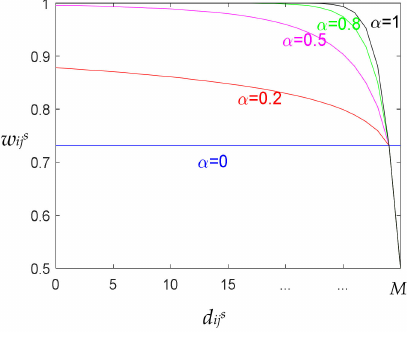
Figure 1. Weight curve with di ff erent α